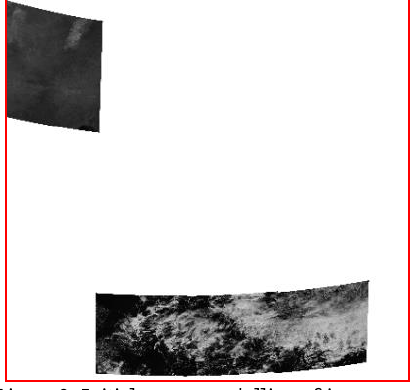
Figure 6. Initial sensor modelling of images not including shoreline